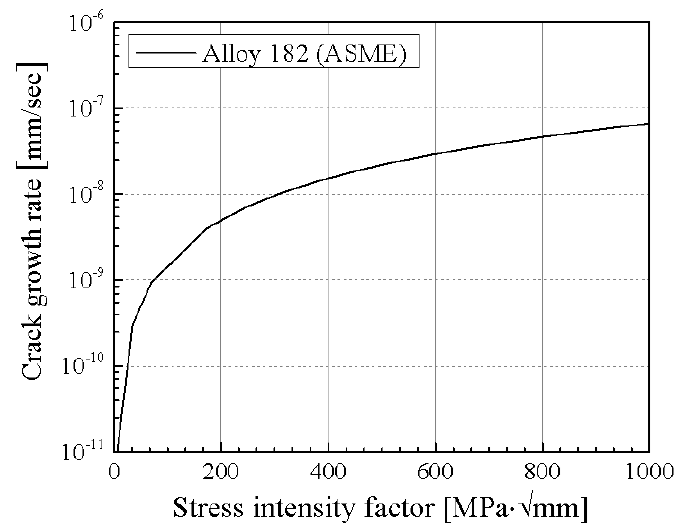
Figure 10. SCC growth rate curve for Alloy 182 presented in ASME code, Sec. XI. Table 6. Parameters of SCC growth.